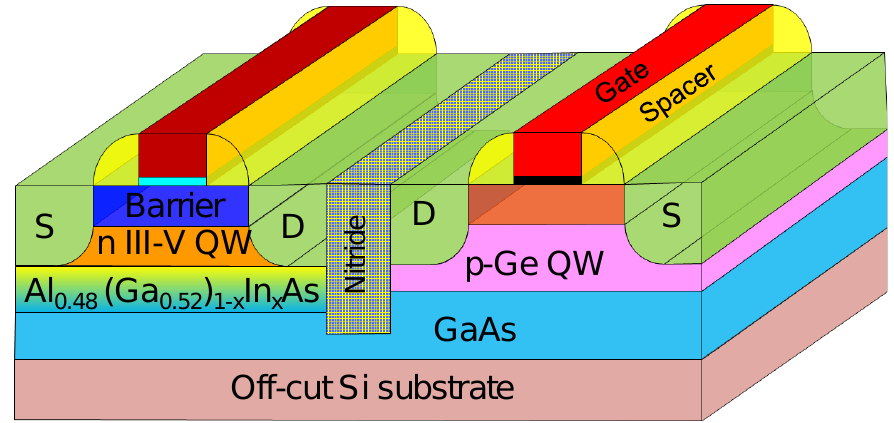
Figure 15. Schematic of extremely-high mobility NMOS and PMOS co-integrated for complete CMOS heterogeneously integrated on